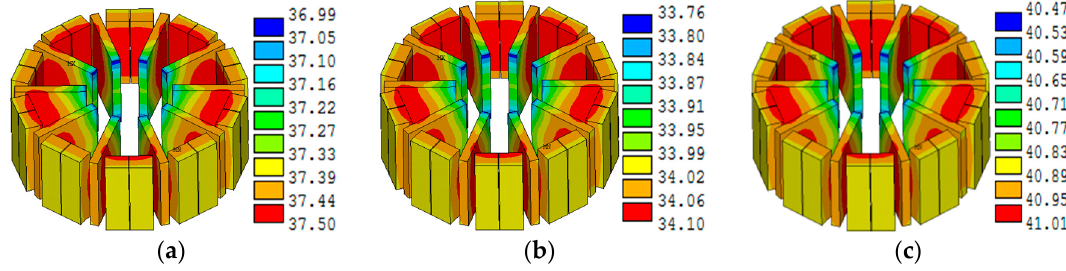
Figure 18. Temperature distribution of the permanent magnets under different AMMF (°C); ( a ) 0 At AMMF; ( b ) 600 At AMMF; and, ( c ) 900 At AMMF.